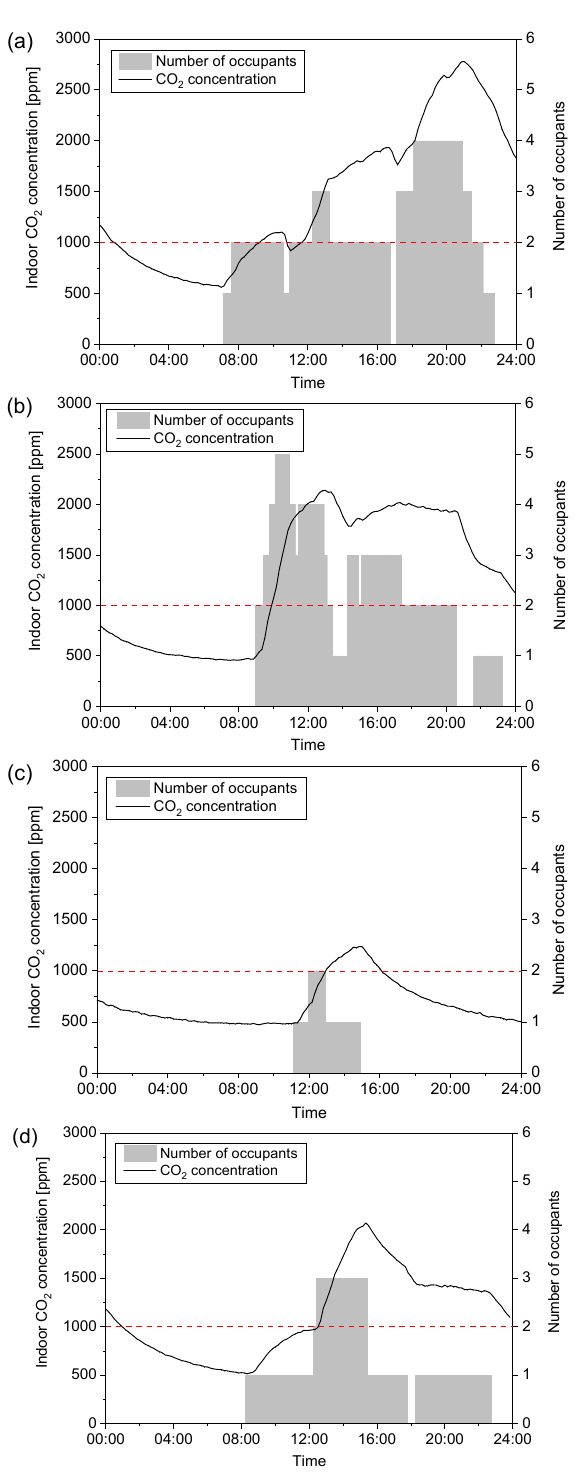
Figure 10. Indoor CO 2 concentration and occupancy rate (door/window closed): ( a , b ) at weekday; ( c , d ) at